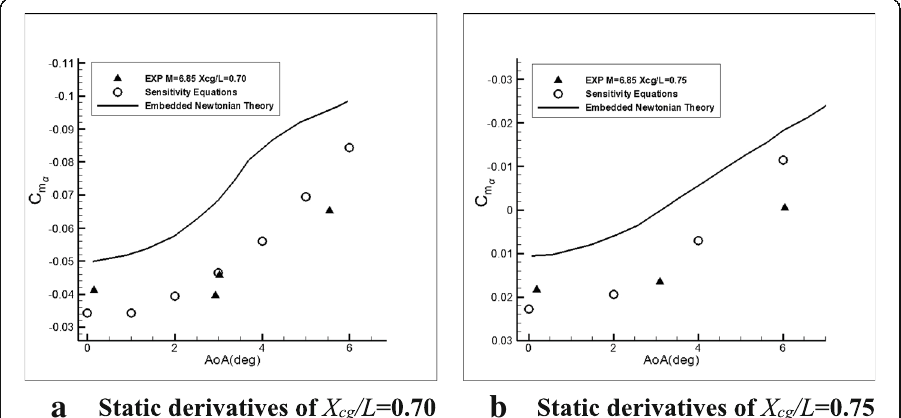
Fig. 7 Comparison of the static of theoretical, experimental and numerical methods for X cg /L = 0.70 and X cg /L = 0.75. a Static derivatives of X cg /L = 0.70. b Static derivatives of X cg /L =